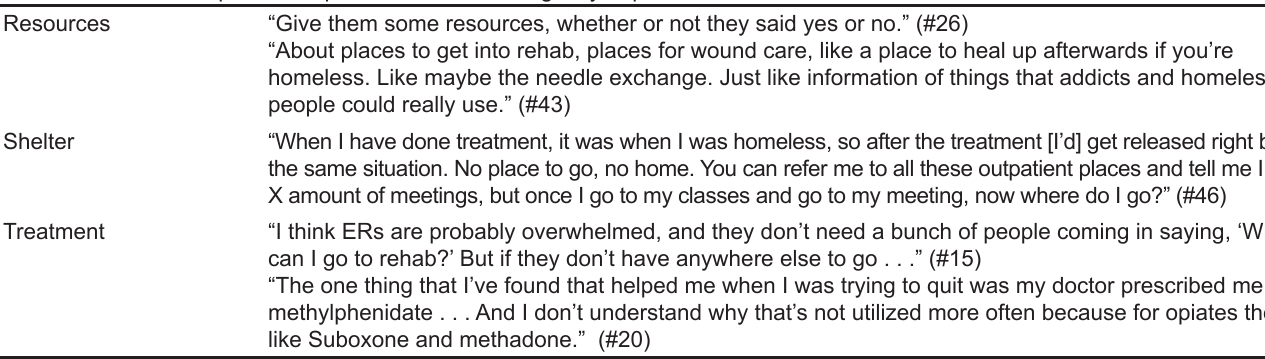
IV , Table 7. Interviewees’ positive experiences in the emergency department.